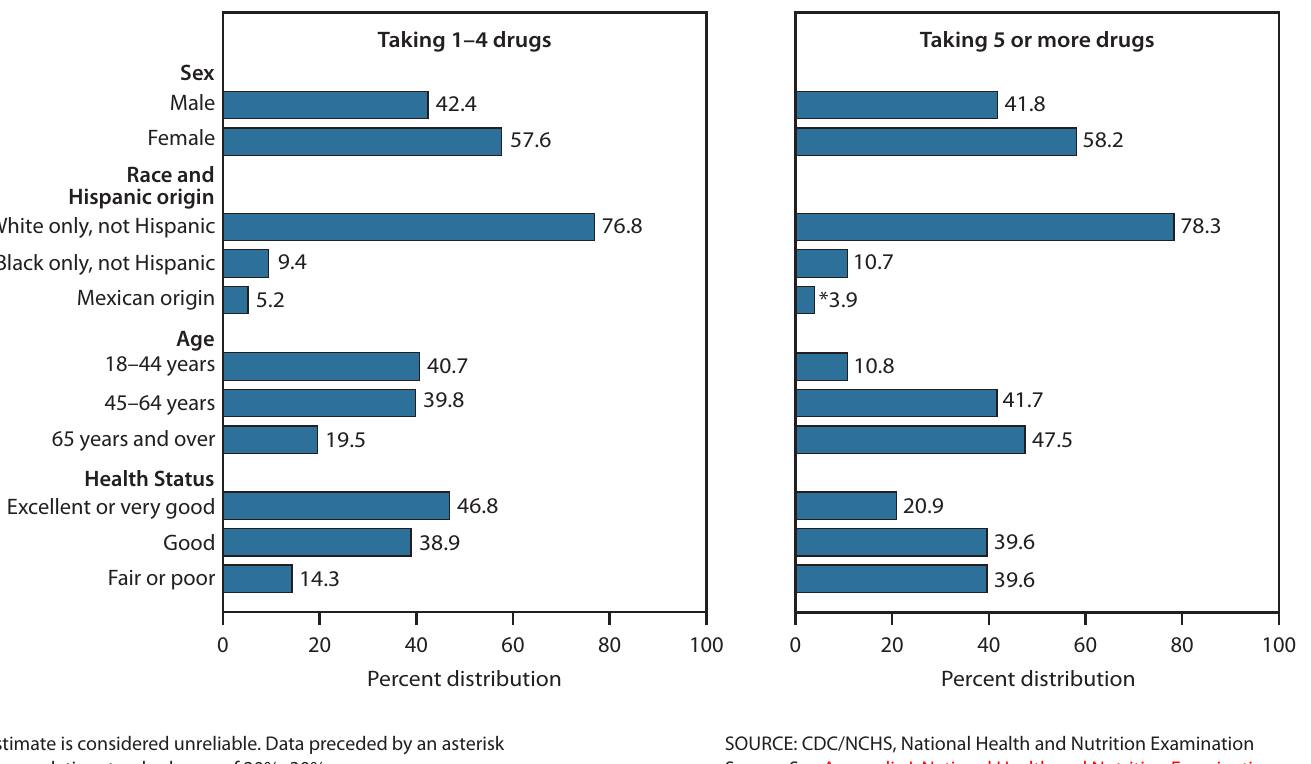
Figure 22. Number of prescription drugs taken in the past 30 days among adults aged 18 and over, by selected characteristics: United States,